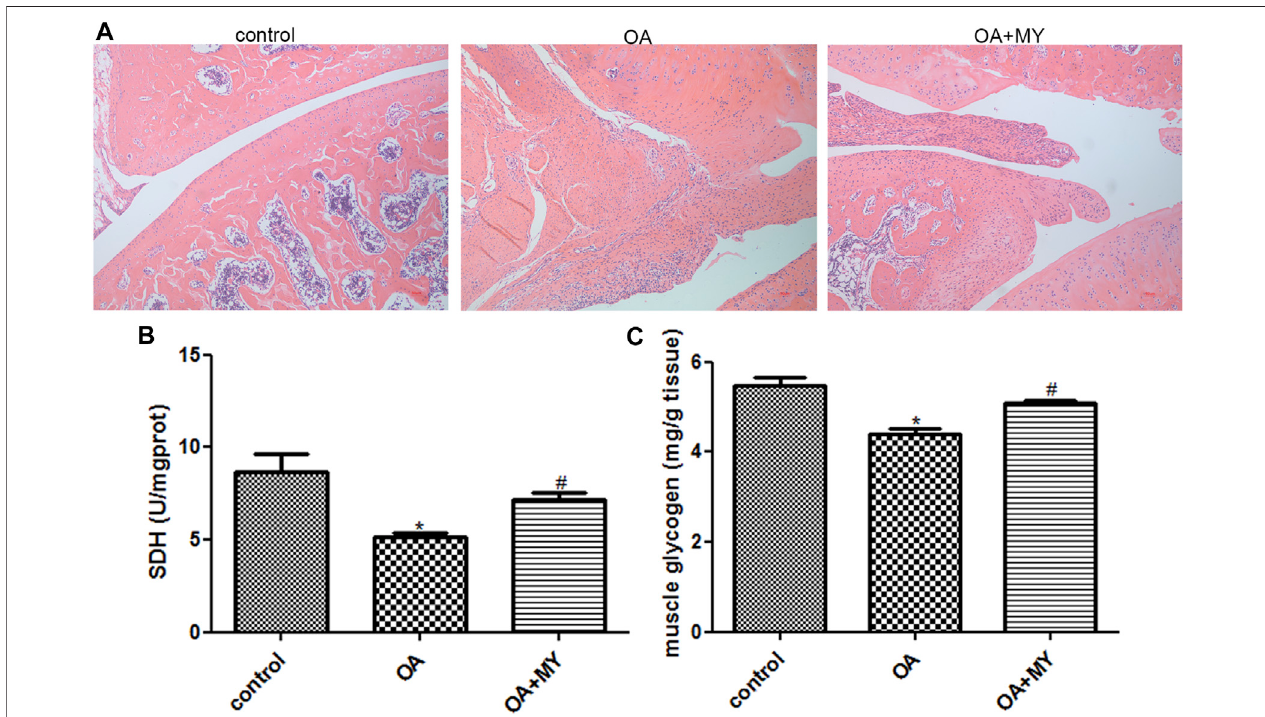
FIGURE 1 | Effects of Miya (MY) on the symptoms and succinate dehydrogenase (SDH) and muscle glycogen (MG) contents in osteoarthritis (OA). (A) Histological changes associated with OAand MY treatment in rats were investigated by hematoxylin-eosin staining under amicroscope at ×100 magni fi cation. (B) Contents of SDH in the tibia muscle of different groups. (C) Contents of MG in the tibia muscle of different groups. * p < 0.05, compared with the control group. # p < 0.05, compared with the OA group.